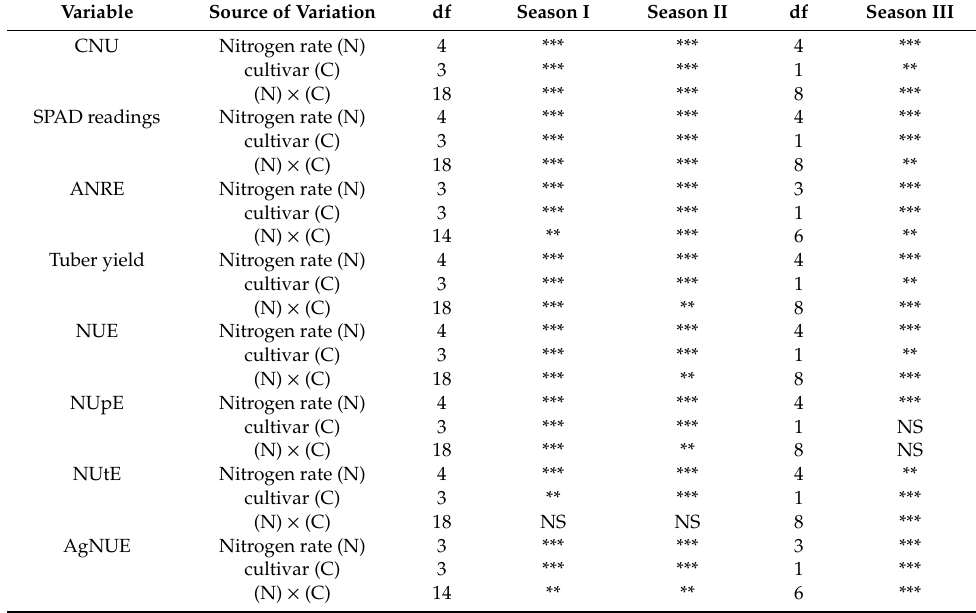
Table 1. Summary of statistical significance from analysis of variance for all studied variables: